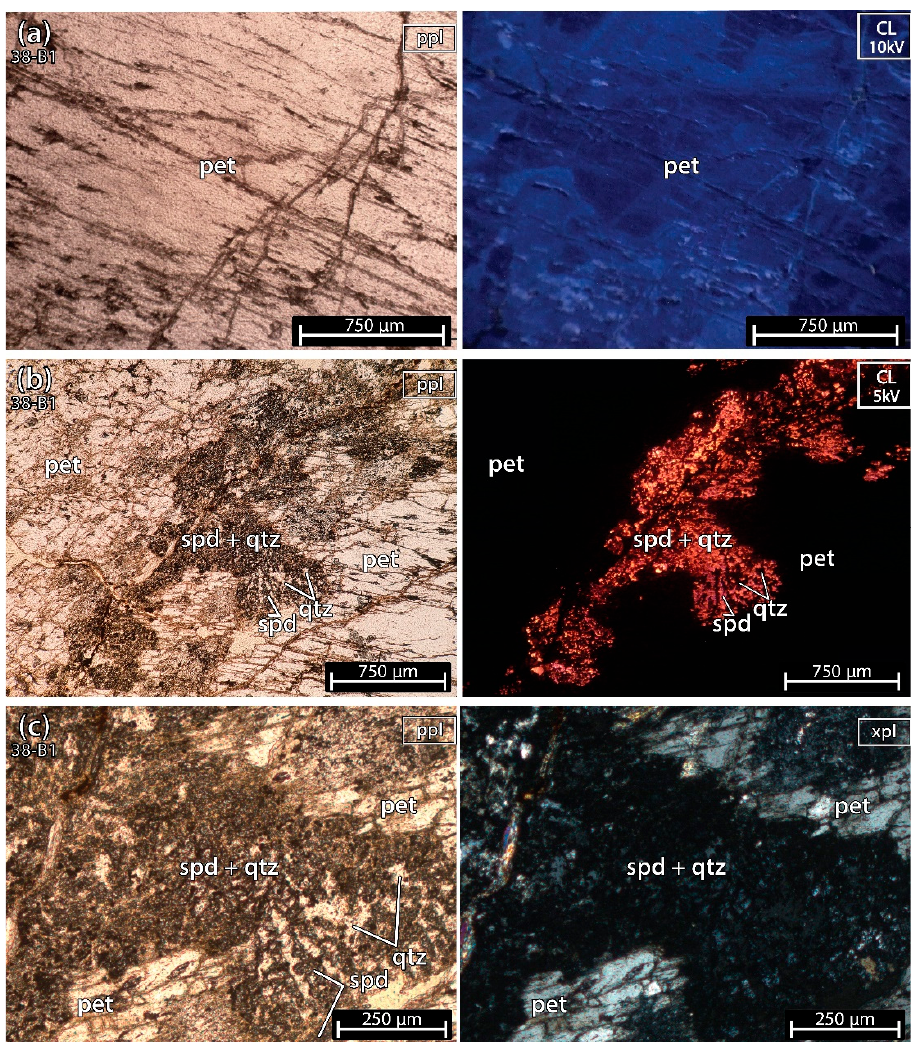
Figure 5 . Microphotographs in parallel polarized light (ppl), crossed polarized light (xpl) and cold cathodoluminescence (CL) microscopy from a petalite (pet) fragment of the crystal sample 1 of the aplite-pegmatite 38 (38-B1). Although most of the sample is petalite, there is an alignment of spodumene (spd) and quartz (qtz) crosscutting the petalite crystal from one side of the thin section to the other. ( a ) petalite; ( b , c ) spodumene and quartz mixture crosscutting the petalite